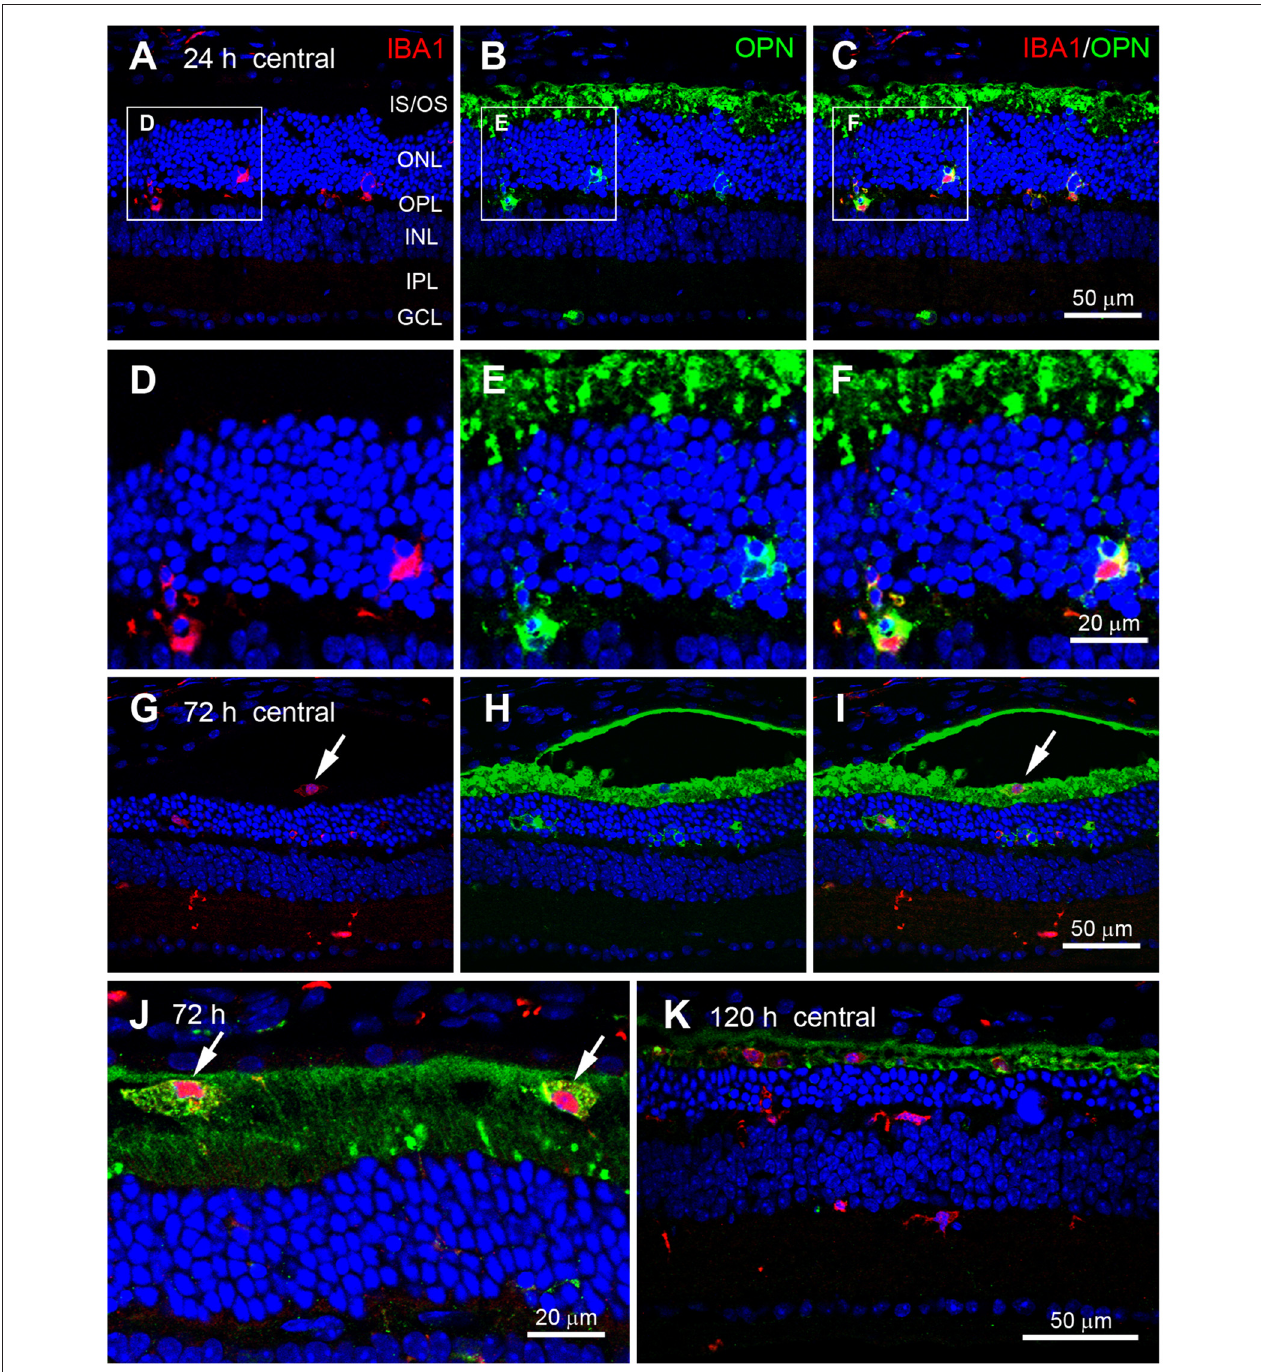
FIGURE 4 | Cellular localization of OPN in blue LED-induced RD retinas. Confocal micrographs taken from vertical sections of blue LED-induced RD retinas processed for OPN (green) and Iba1 (red) immunoreactivity. (A–F) A representative RD retina at 72 h after blue LED exposure. OPN was observed in Iba1-labeled microglia (arrows) in the ONL and OPL. INL, inner nuclear layer; IPL, inner plexiform layer; IS/OS, inner segment and outer segment; ONL, outer nuclear layer; OPL, outer plexiform layer; RPE, retinal pigment epithelium. A region including two OPN-labeled microglia in (A–C) are magnified in (D–F) , respectively. OPN was localized in the processes of Iba1-labeled microglial cells. (G–J) A representative RD retina at 72 h after blue LED exposure. Iba1-labeled cells were observed in the INL, IPL, and subretinal space. OPN was observed in Iba1-labeled microglia of the ONL and microglia/macrophages of the subretinal space (arrow), while OPN expression was not observed in Iba1-labeled microglia of the INL or IPL. Two microglia/macrophages (arrows) showing Iba1 and OPN co-labeling are magnified in (J) . (K) A representative RD retina at 120 h after blue LED exposure. Several Iba1-labeled microglia/macrophages were still observed in the ONL and subretinal space, while minimal OPN-labeling was observed in the ONL and subretinal